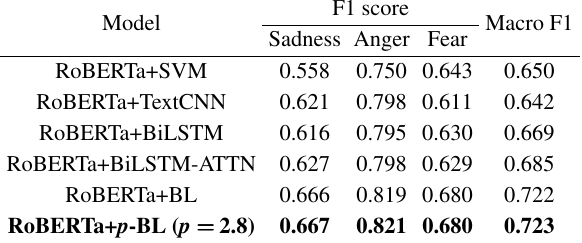
Table 5 Performance of different methods on Usual dataset.